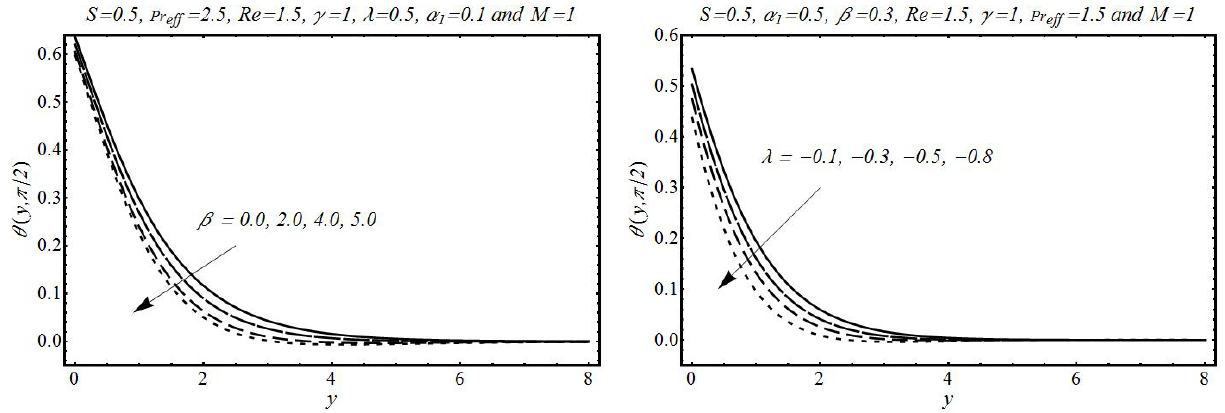
Figure 11: Effects of β on temperature